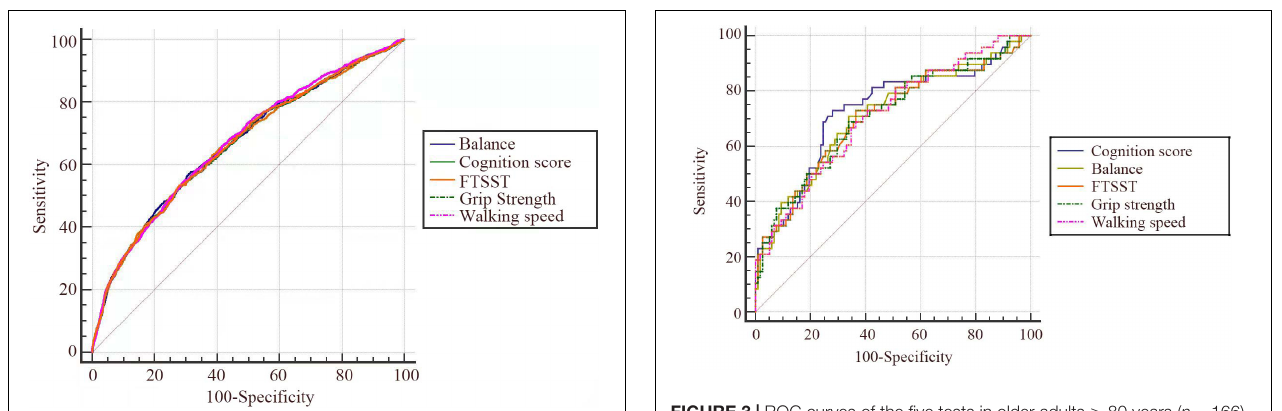
FIGURE 3 | ROC curves of the five tests in older adults ≥ 80 years ( n = 166). TABLE 5 | The AUC of the five tests in older adults ≥ 80 years ( n =